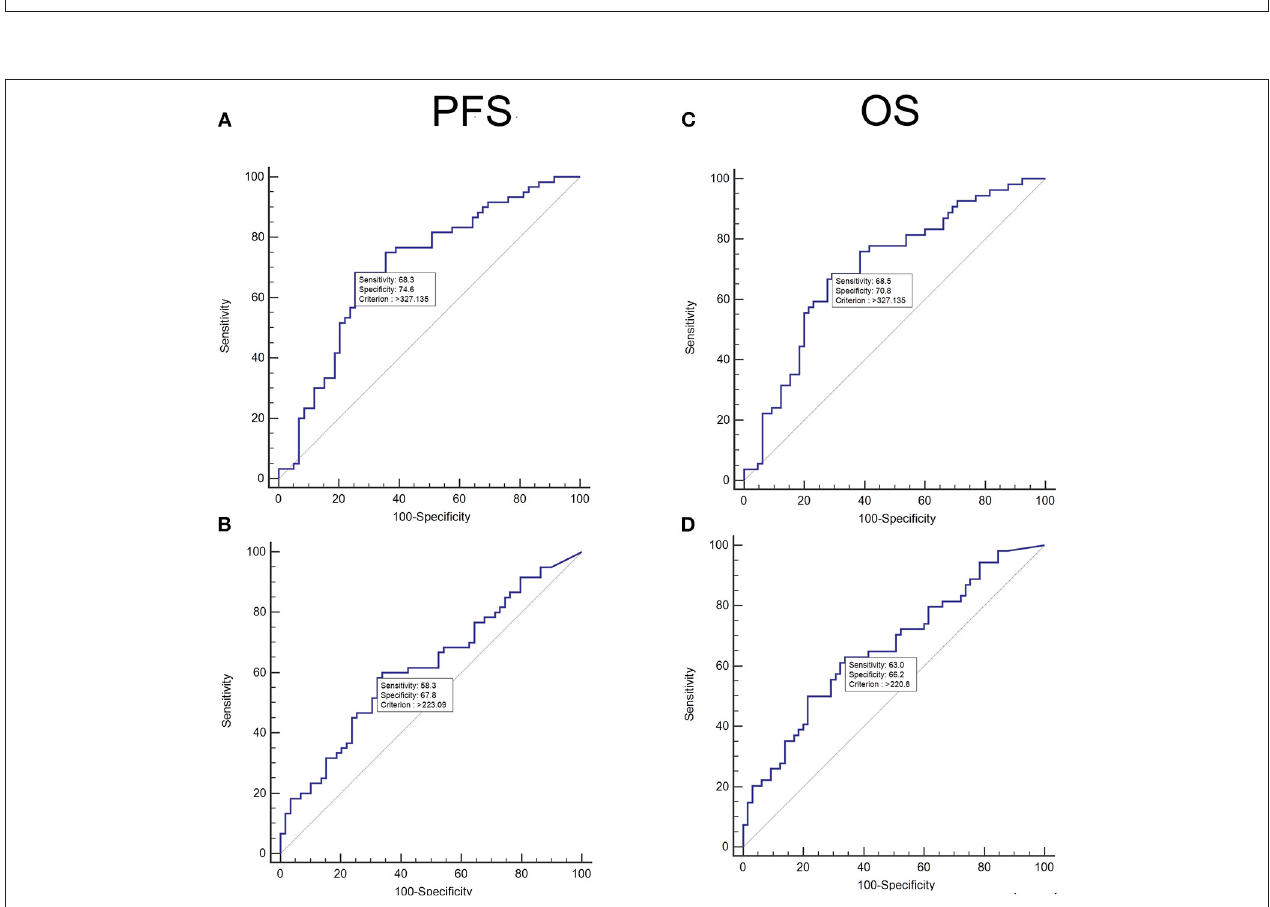
FIGURE 2 | Receiver operating characteristic (ROC) curve analysis of the population of diffuse large B-cell lymphomas (clinical research database) for progression-free survival (PFS) for manually obtained total metabolic tumor volumes (TMTVs) (A) and automatically obtained TMTVs (B) and for overall survival (OS) for manually obtained TMTVs (C) and automatically obtained TMTVs (D)